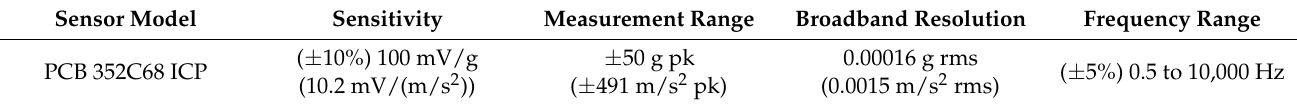
Figure 26. ( a ) Structure of the machinery fault simulator. ( b ) AC motor with acceleration sensor mounted.